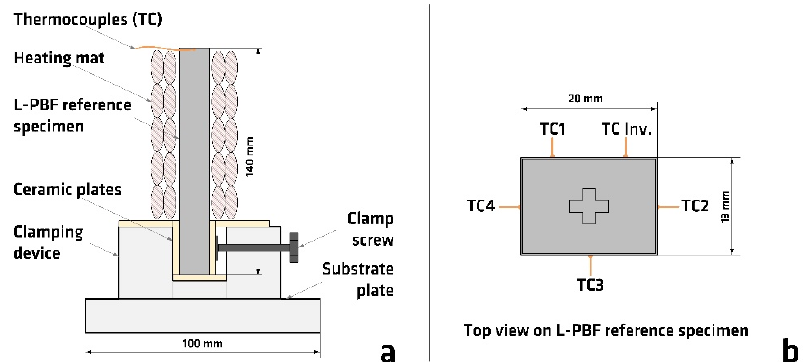
Figure 4. ( a ) schematic of heating device without outer insulation; ( b ) schematic of specimen surface indicating TC positions.